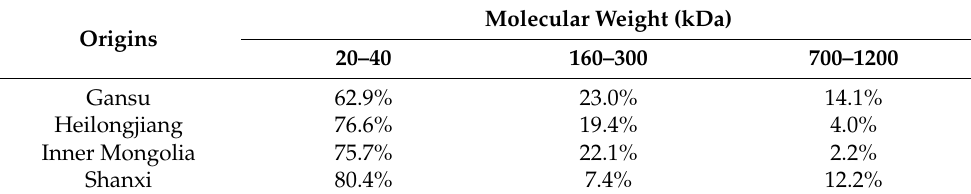
Table 2. Percentages of APS fractions with different molecular weights.